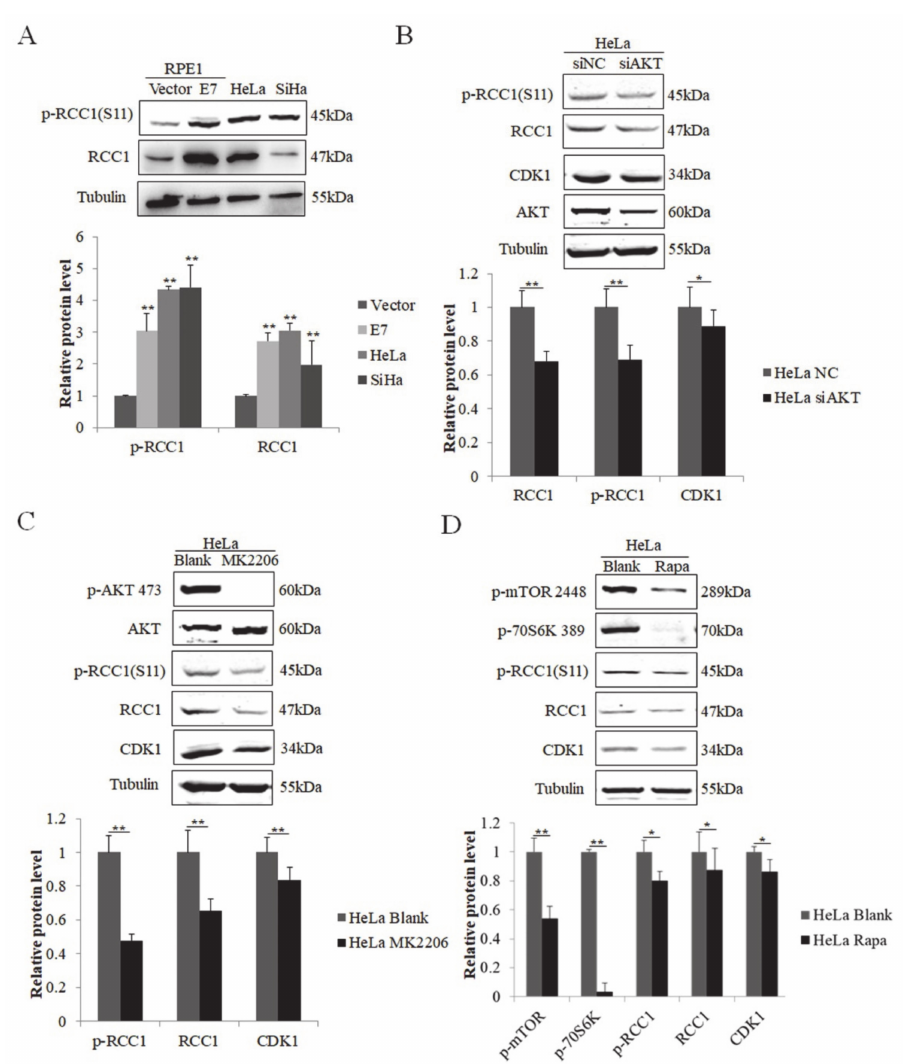
Figure 5. Phosphorylation of RCC1 S11 was increased by the PI3K/AKT/mTOR pathway in HeLa cells. ( A ) RCC1 and p-RCC1(S11) protein levels in RPE1-Vector, RPE1-E7, HeLa and SiHa cells were detected by Western blot. ( B ) Expression of RCC1, p-RCC1(S11), CDK1, AKT in HeLa cells after AKT knockdown. ( C ) Western blot analysis of p-AKT 473, AKT, RCC1, p-RCC1(S11), CDK1 in HeLa cells treated with MK2206. ( D ) HeLa cells were treated with Rapa, and p-mTOR 2448, p-70S6K 389, RCC1, p-RCC1(S11), CDK1 protein levels were measured by Western blot. Data shown are representative of 3 biological replicates. * p < 0.05; ** p <